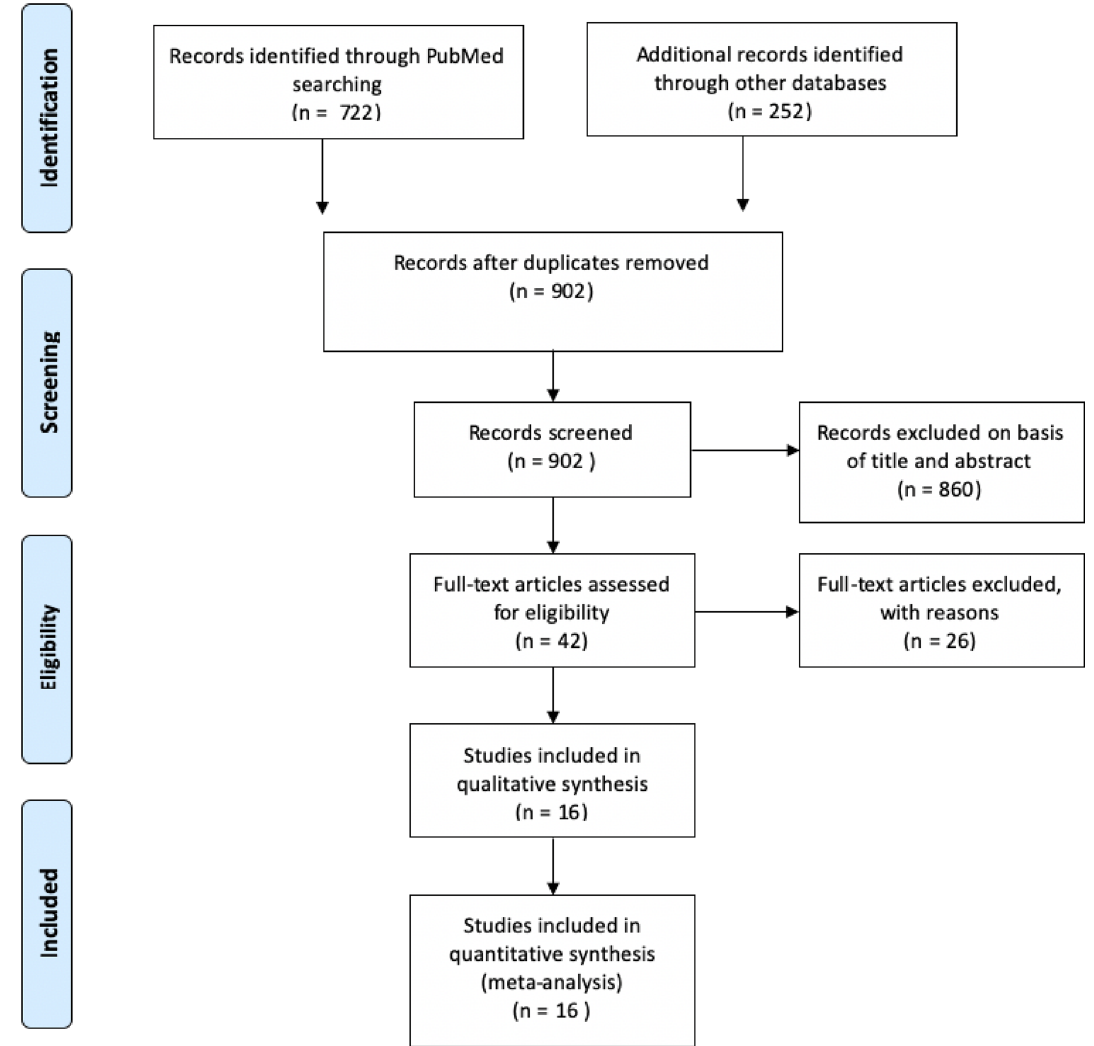
Figure 1. Prisma diagram of literature search and